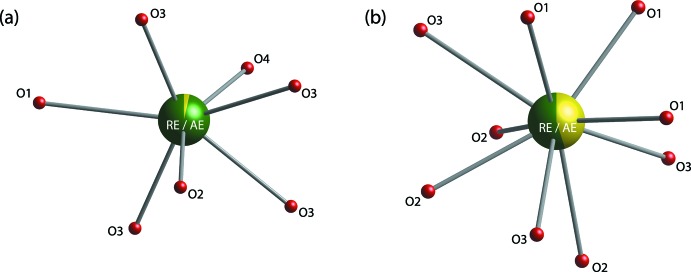
(a) Seven-coordinated and (b) nine-coordinated oxygen atoms around RE/AE cations for Ca2
RE
8(SiO4)6O2.